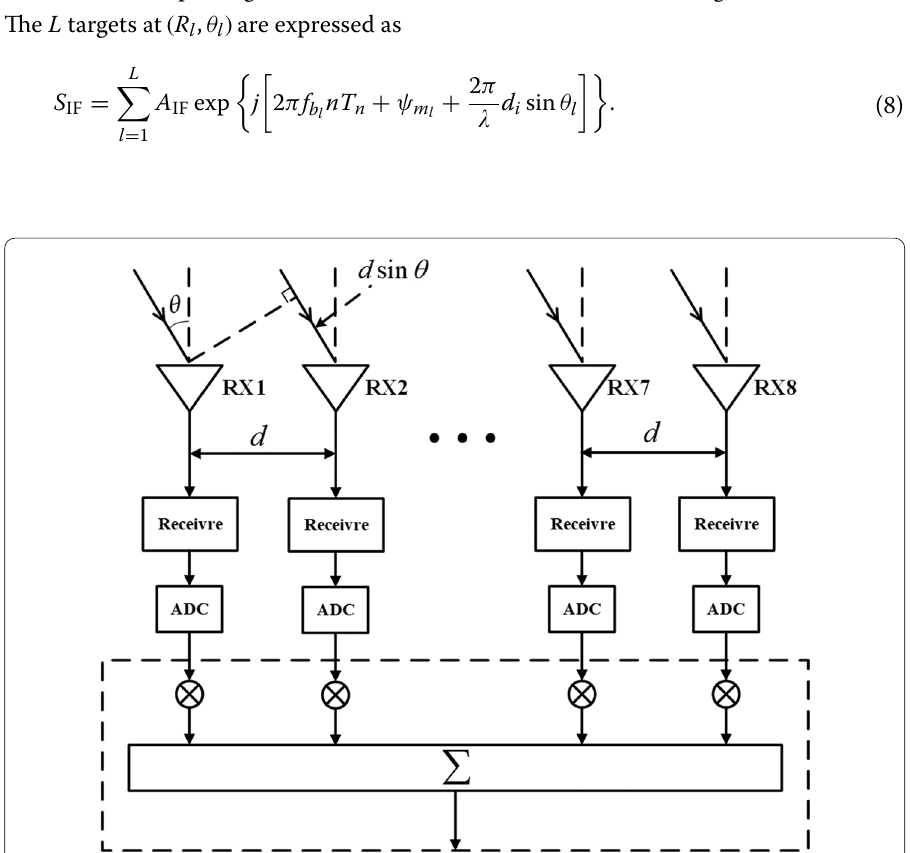
Fig. 2 Signal receiving model of array